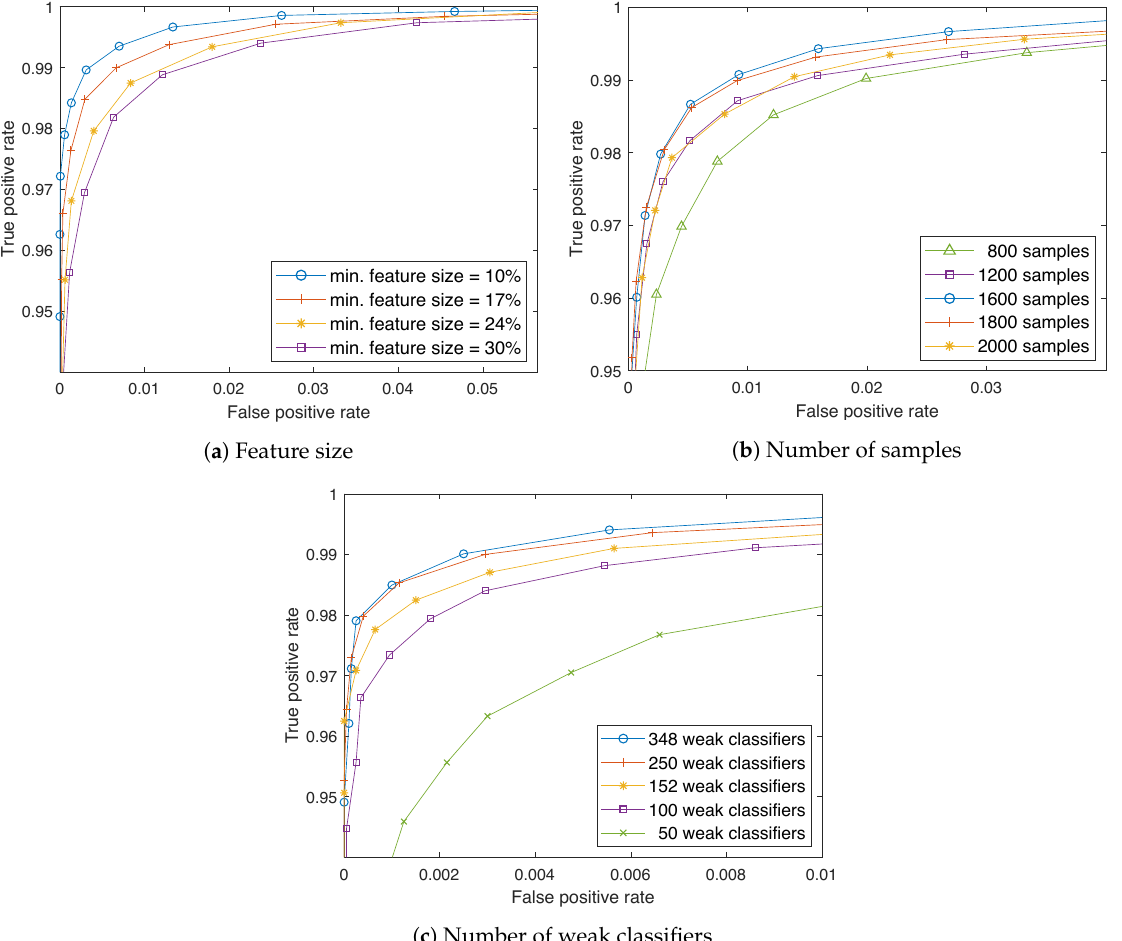
Figure 6. ROC curves indicating the effect of different hyperparameters on the detection